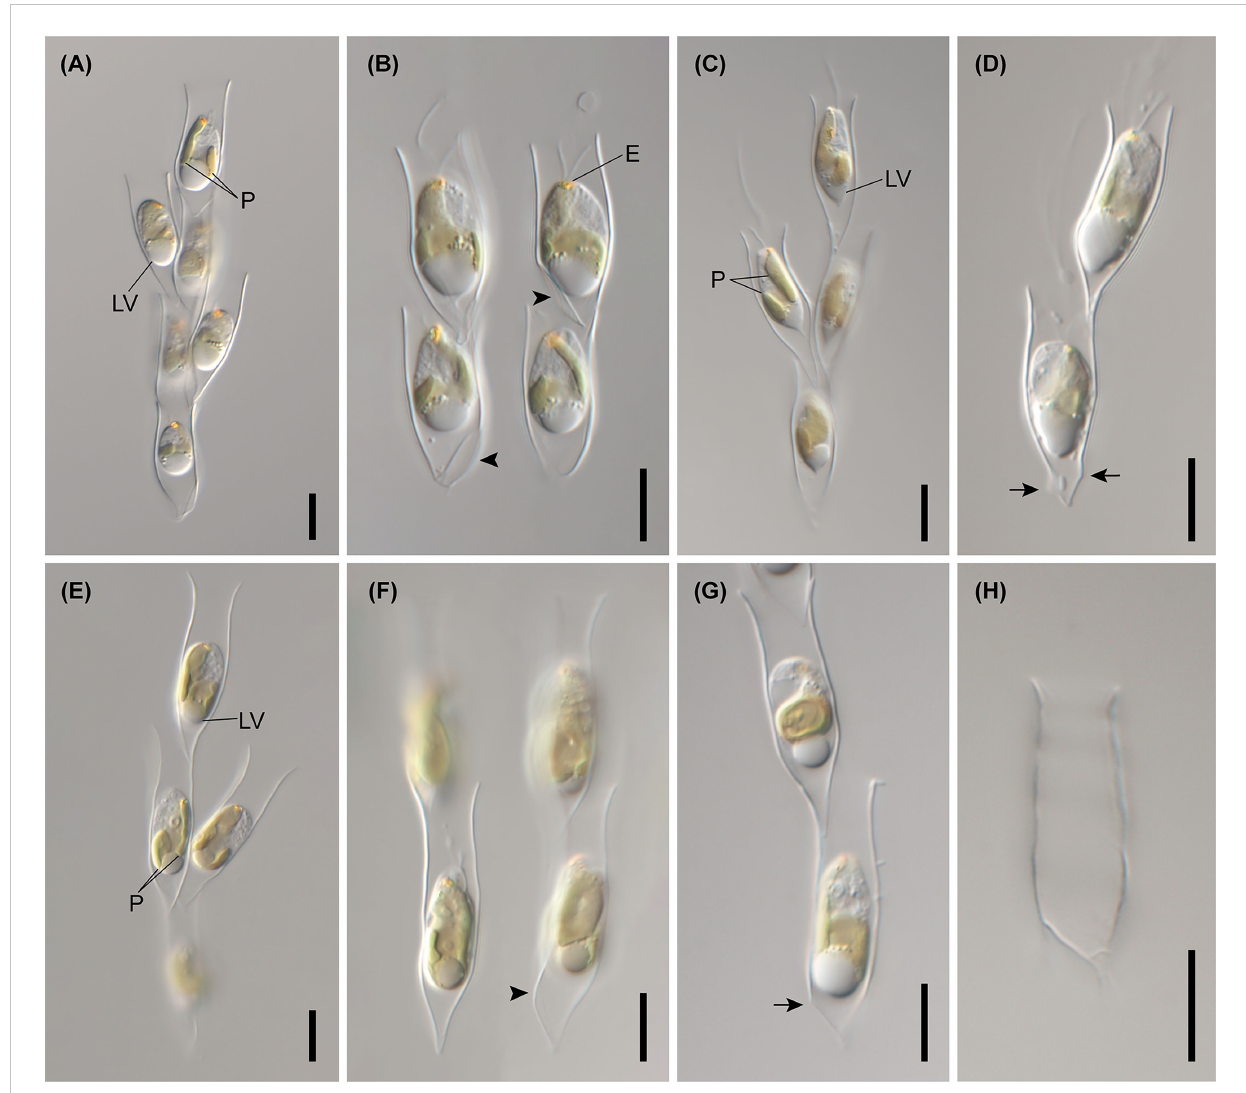
FIGURE 7 Light micrographs of Dinobryon species. (A, B) Images of D. ningwuensis Yeongrangho111321MS1. One side of the lower lorica cone was caved in (arrowhead). (C, D) Images of D. taiyuanensis Yookho031321MS4. Two protuberances are in both sides of the lower lorica part (arrow). (E – H) Images of D. inclinatum Chojeon011219A. Lower lorica part was inclined to one side (arrowhead). E, eyespot; LV, leucosin vesicle; P, plastid. Scale bars = 10